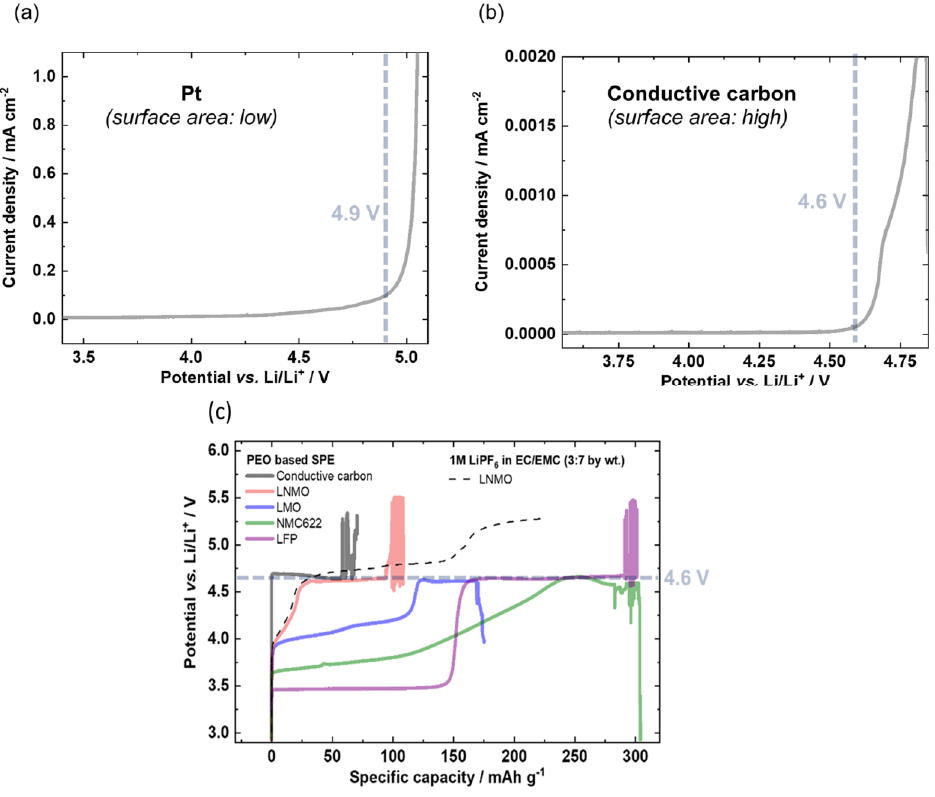
Figure 7. LSVs of PEO based SPE with a scan rate of 0.1 mV/s on ( a ) Pt and ( b ) conductive carbon working electrode resulting in an exponential increase in current density of 4.9 and 4.6 V vs. Li/Li + , respectively. ( c ) Determination of the onset of main oxidation of PEO based SPEs via overcharge of the working electrode with a specific current of 15 mA g − 1 using different positive electrodes. Extract with permission from ref. [124]. Copyright 2020 Springer